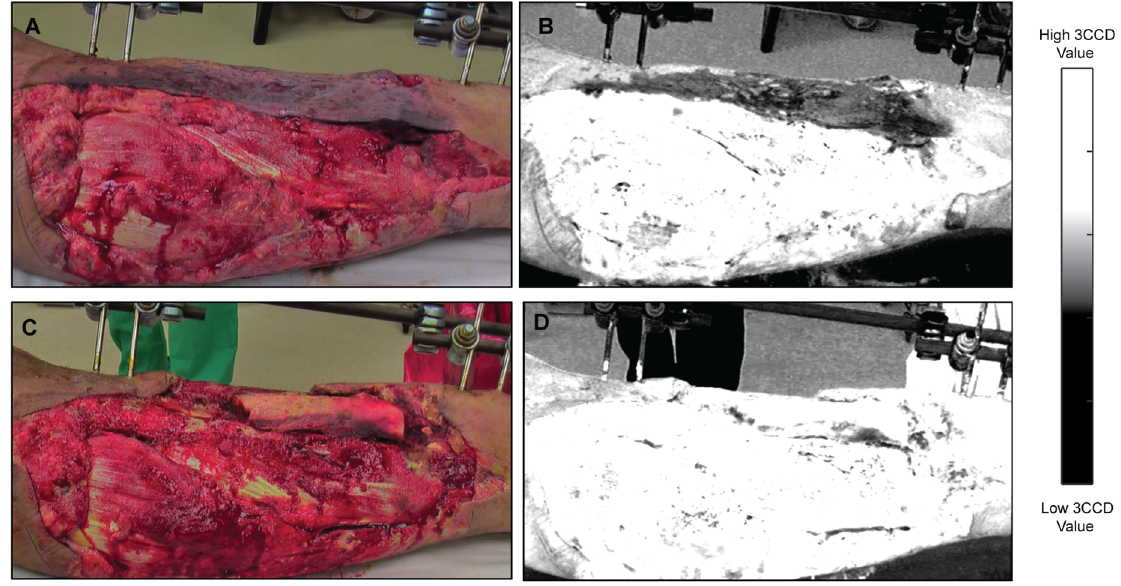
Fig 1. Regular 3CCD images (color) collected during a civilian trauma case (Emory/Grady) and the corresponding contrast enhanced images (grayscale); in this case, the wound healed normally. First de´bridement (A) from a healed wound and its corresponding contrast enhanced image (B). Last de´bridement (C) from the same case and the corresponding enhanced image (D). White regions have a higher 3CCD value while black regions have a lower 3CCD value given the fewer photons captured in that color spectrum by the camera. Note, there is little or no difference between the first and final de´bridement 3CCD values of the wound bed.